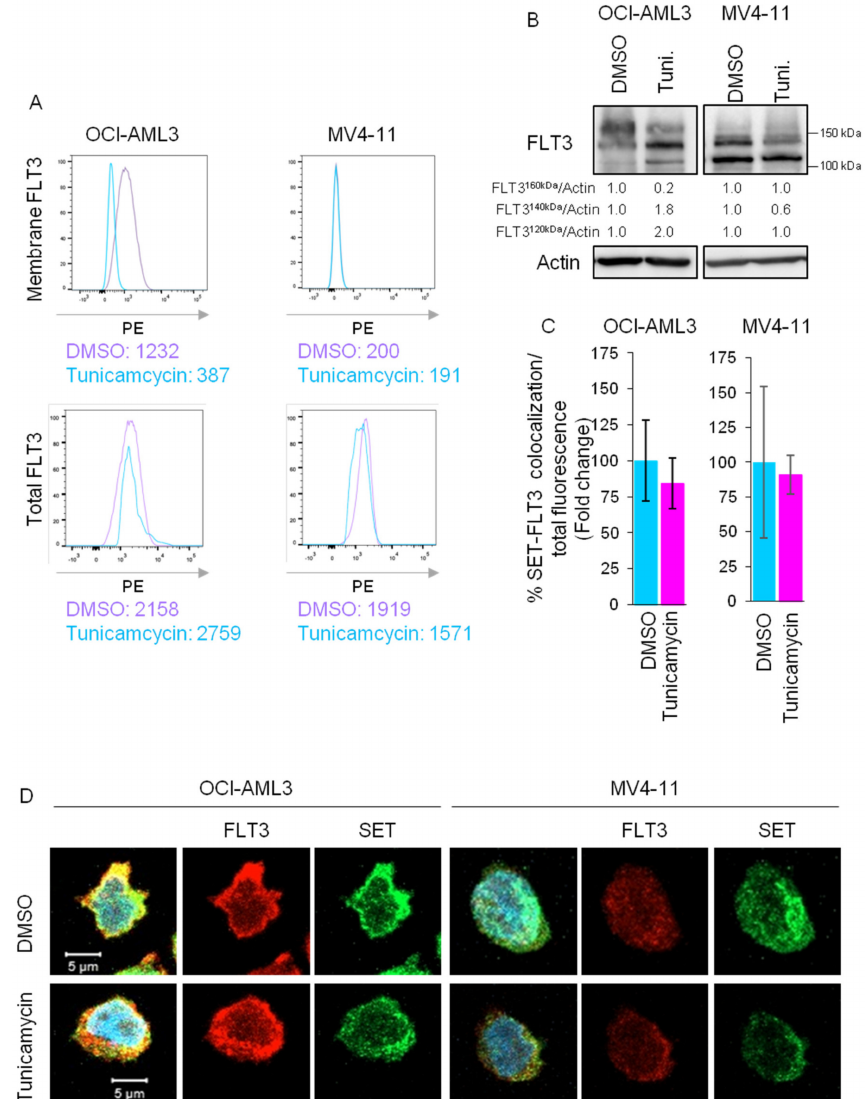
Figure 4. Glycosylation inhibition decreases FLT3 in the membrane but does not disrupt SET/FLT3 interaction in FLT3-WT AML cells. AML cell lines OCI-AML3 (FLT3-WT) and MV4-11 (FLT3-ITD) were treated with tunicamycin (200 µ g/mL) for 24 h ( A ) FACS analysis of membrane FLT3 in AML cells without permeabilization and total FLT3 in permeabilized cells. Inhibition of the glycosylation decreased membrane FLT3 in FLT3-WT but not in FLT3-ITD cells without changing total FLT3 levels. Numbers represent mean PE fluorescence intensity. Representative image from more than 4 experiments is shown. ( B ) Western blot analysis of FLT3 after tunicamycin treatment in OCI- AML3 and MV4-11 cells. Quantification of the relative FLT3 bands demonstrated a decrease in the 150 kDa mature band along with an increase in <150 kDa immature bands in FLT3-WT cells but not in FLT3-ITD cells. A representative western blot is shown. ( C ) Bar graphs representing quantification of Mean values ± SD of SET and FLT3 co-localization referred to total cell volume, demonstrating that SET/FLT3 interaction is not disrupted after glycosylation inhibition. ( D ) Immunofluorescence of SET (green) and FLT3 (red) in AML cell lines. Confocal microscopy showed co-localization (yellow) of both proteins even after glycosylation inhibition. Nuclei are stained with DAPI (blue). The scale bar represents 5 µ m. The uncropped bolts are shown in Supplementary Materials File